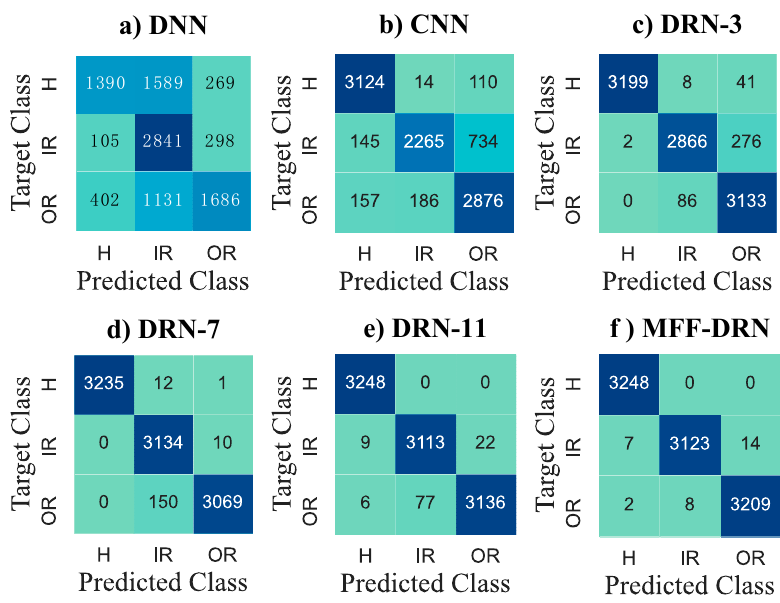
Figure 8. Confusion Matrix Comparison in Case 1.